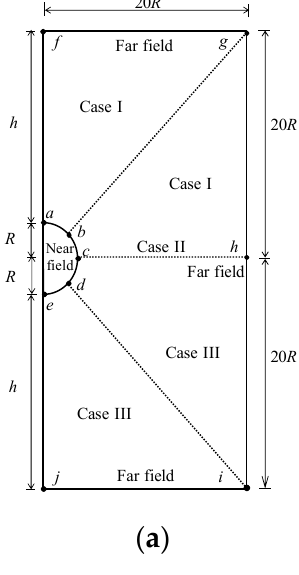
Figure 6. ( a ) Assumptions of three different boundary conditions with the initial anisotropic stress in different far-field conditions and ( b ) finite element mesh and boundary condition.